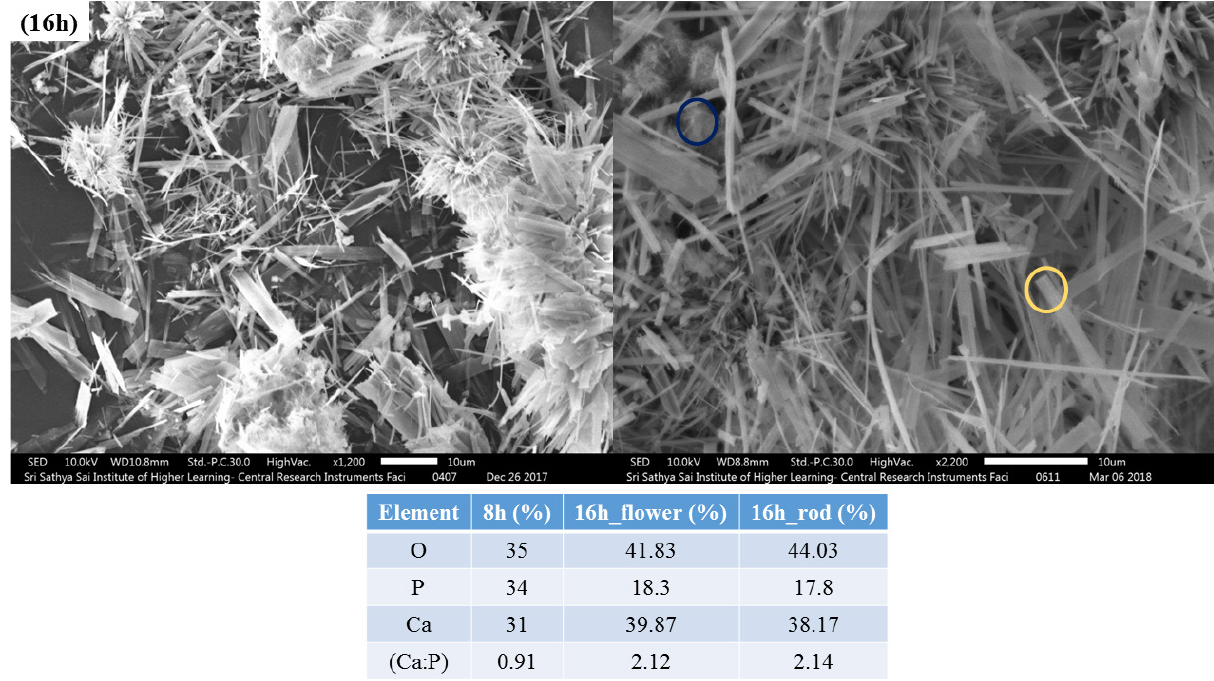
Figure S5: SEM images and corresponding EDX report of the composition of the nano-hydroxyapatite in the rod and flower composition at 16h dwell time of hydrothermal synthesis at 10 µ m resolution